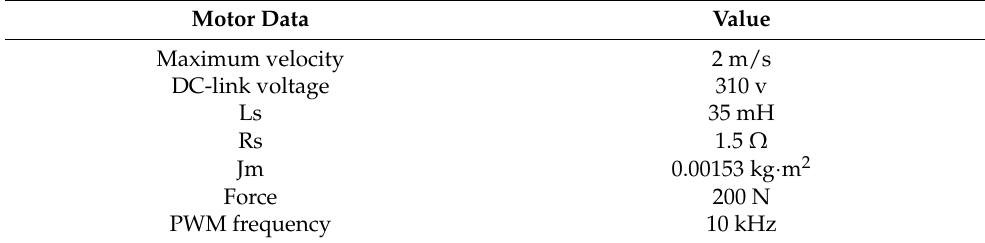
Figure 6. The diagram of the WS-PMLM sensorless drive. Table 1. The parameters of the